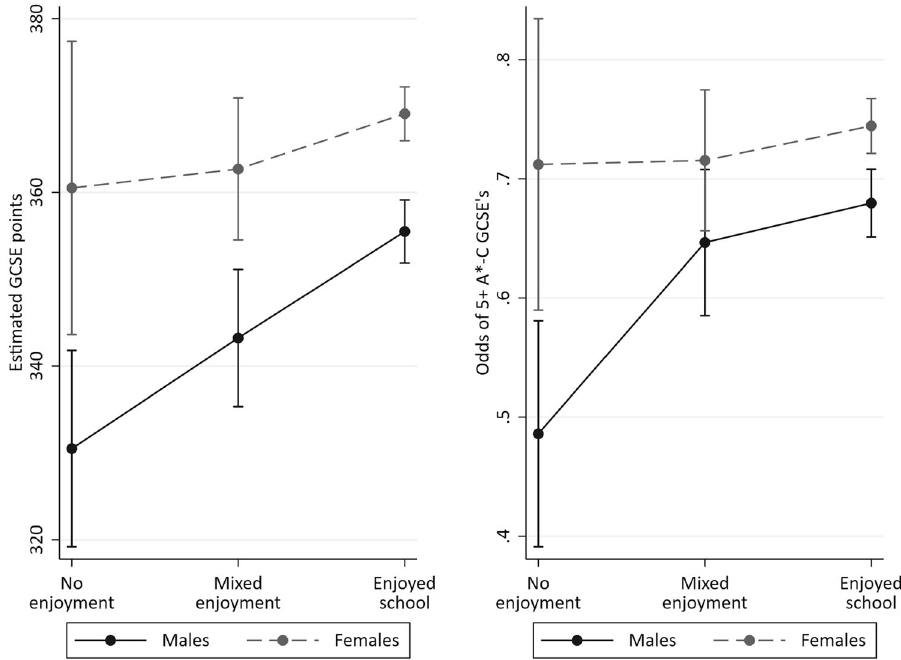
Fig. 1 Interaction between school enjoyment and sex on GCSE achievement (capped points score). Left: linear regression of GCSE point scores. Right: odds ratios of attaining 5 + A*-C GCSE grades including Maths and English. GCSE General Certi fi cate of Secondary Education. Bars represent con fi dence